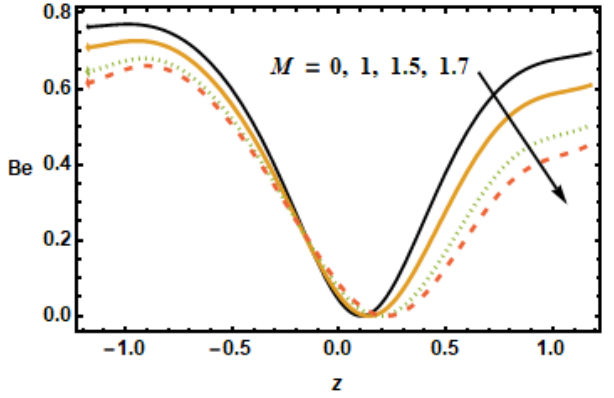
Figure 25. Effects of Hartman number M on Be .